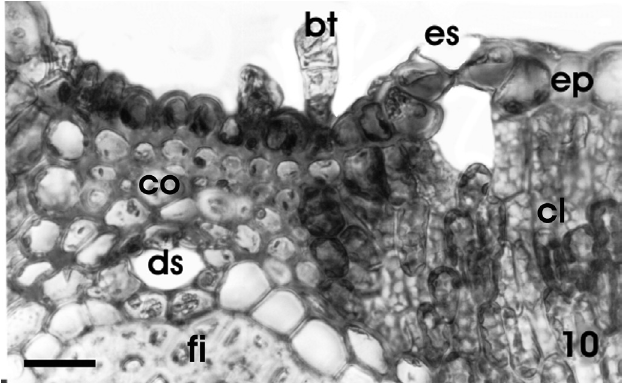
FIGURA 10 – B. microcephala – Detalhe do eixo caulinar, em secção transversal. bt: base de tricoma; cl: clorênquima; co: colênquima; ds: duto secretor; ep: epiderme; es: estômato; fi: fibras esclerenquimáticas. Barra = 20 µ m.